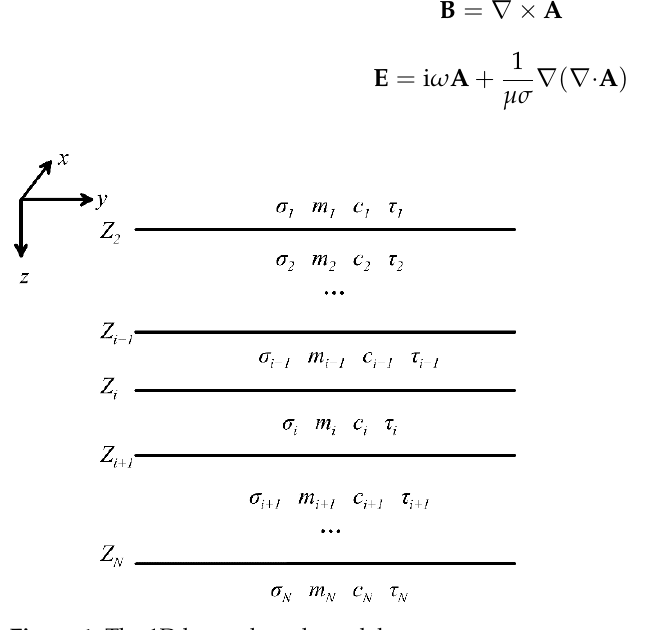
Figure 1. The 1D layered-earth model.